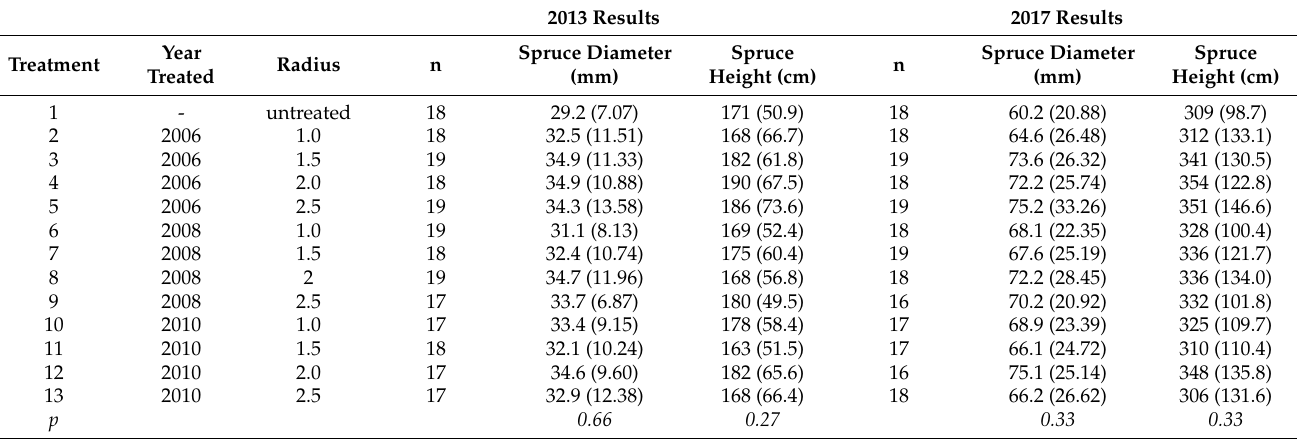
Table 5. Summary of treatment effects on spruce diameter (D15) and height for the 3 blocks at Lac La Biche in 2013 and